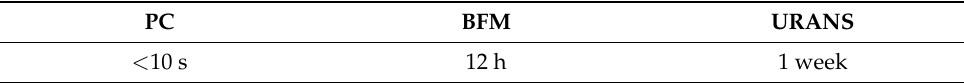
Table 2. Typical user time for 1 operating point with distortion.